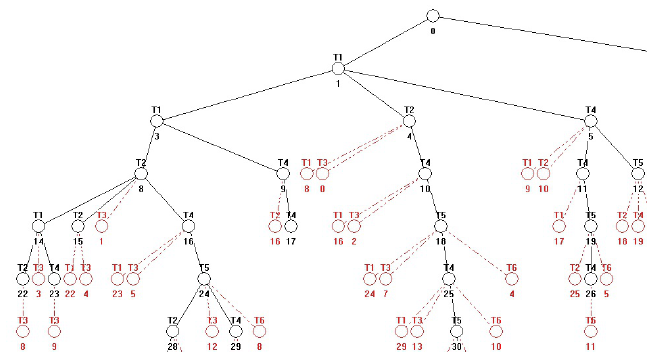
Figure 2. The principal fragment of the